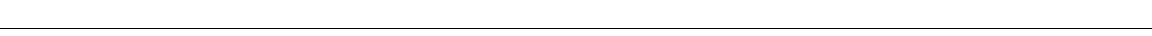
Fig. 3 Sth -independent Thpok repression by Bcl11b in pre-selection DP thymocytes. a Quantitative RT-PCR showing amount of promoter-speci fi c Thpok transcripts in splenic CD4 + T cells and splenic B220 + B lymphocytes. Summary of three measurements. b Quantitative RT-PCR for Thpok-gfp expression in CD4 + T cells from mutant reporter alleles, Thpok gfp: Δ TE and Thpok gfp: Δ PE , lacking the thymic enhancer ( TE ) or proximal enhancer ( PE ), respectively. Levels of P1- and P2 promoter-speci fi c transcripts relative to those from the control Thpok gfp allele harboring intact enhancers is shown. One representative of two independent experiments. c Promoter-speci fi c Thpok transcripts in Bcl11b m/m pre-selection DP thymocytes and CD4 + T cells relative to those in control CD4 + T cells. Summary of three measurements. d Histograms showing Thpok-GFP expression from the Thpok gfp: Δ TESPE allele in the indicated cell subsets differentiated in Rag1-de fi cient recipients from control ( dotted line ) and Bcl11b m/m ( solid line ) fetal liver cells. Expression pattern of Thpok gfp is shown as reference ( shaded ). Schematic structure of the Thpok gfp: Δ TESPE allele is included ( upper panel ). One representative of two independent experiments. e ATAC- seq tracks at the Thpok locus in CD24 hi TCR β lo CD4 + CD8 + pre-selection thymocytes of 6-week-old Bcl11b + / + mice, newborn Bcl11b + / fl :Lck-cre , newborn Bcl11b HM/ fl :Lck-cre and newborn Bcl11b HM/HM :Lck-cre mice. ATAC-seq results in immature B cells (GSM2123187) is shown as reference. DP thymocyte- and B lymphocyte-speci fi c peaks are marked with blue and red arrowheads , respectively. Position of the P1 promoter is indicated with black